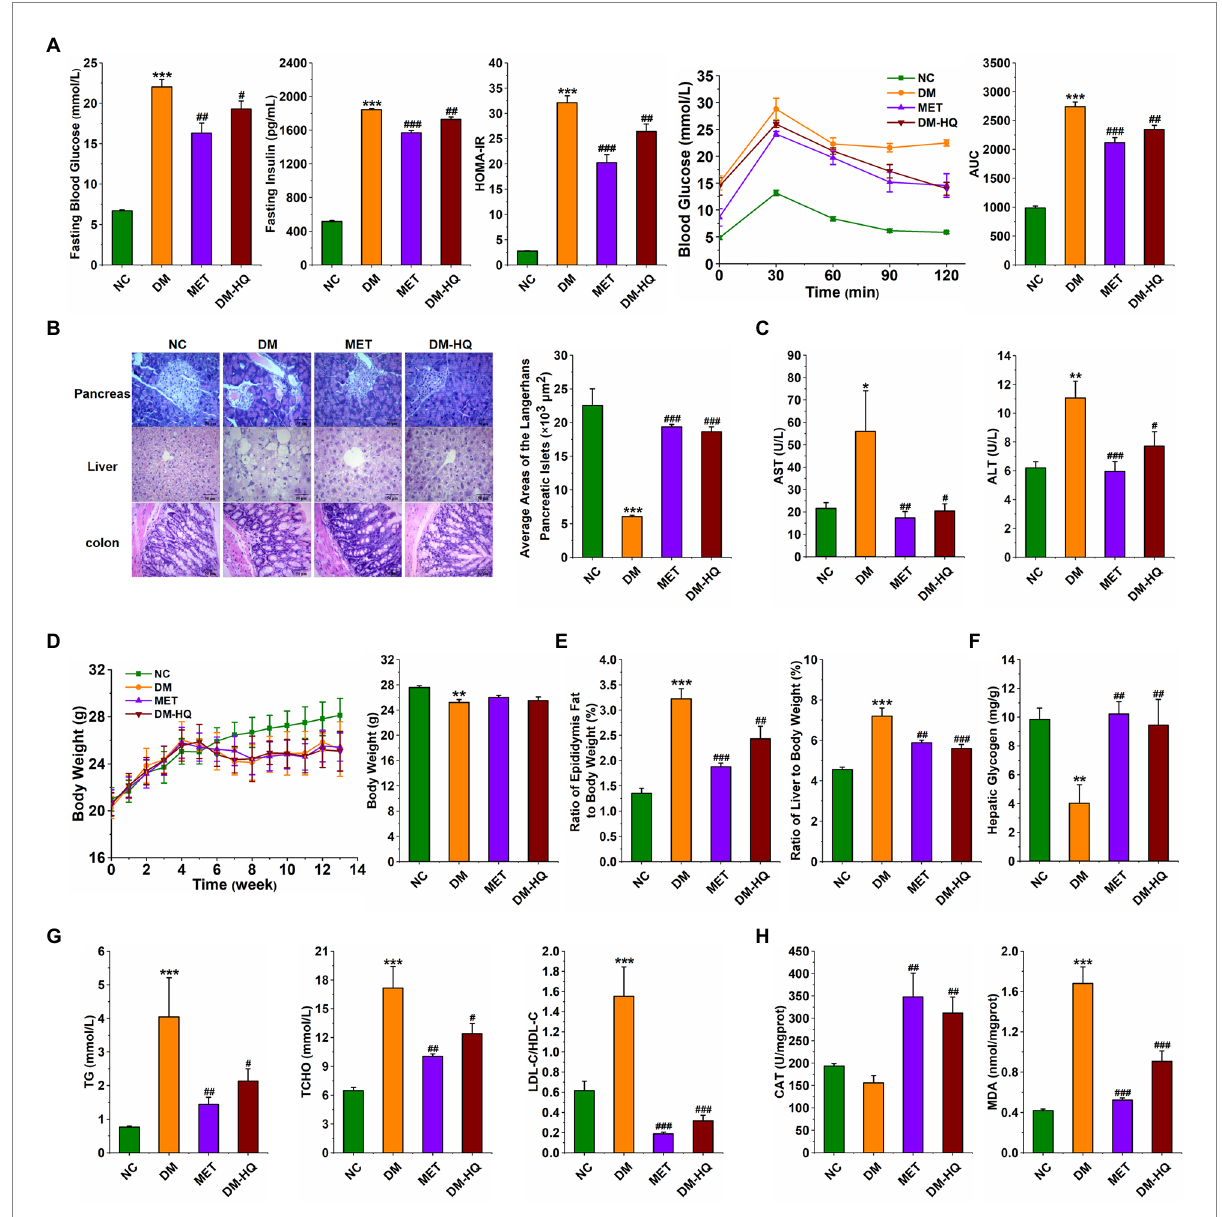
FIGURE 1 Huang-Qi-Ling-Hua-San (HQLHS) attenuated HFD and STZ induced type 2 diabetes. (A) Fasting blood glucose, fasting insulin level, homeostasis model assessment-insulin resistance (HOMA-IR), oral glucose tolerance test (OGTT), and area under the curve (AUC). (B) Morphological observation of pancreas (magnification, ×200, 50 μ m), liver (magnification, ×200, 50 μ m), colon (magnification, ×400, 50 μ m) with H&E staining, and the average area of the pancreatic islets of Langerhans. (C) Serum levels of aspartate aminotransferase (AST) and alanine aminotransferase (ALT). (D) The weekly weight change and the final weight at 13th week in the four groups. (E) Epididymal fat index and liver index. (F) Level of hepatic glycogen. (G) Blood triglycerides, cholesterol, LDL-C/HDL-C levels. (H) Serum levels of Catalase (CAT) and malondialdehyde (MDA). Data are expressed as mean ± SEM; One-way ANOVA was used to analyze statistical differences; Compare to NC: * p < 0.05; ** p < 0.01; *** p < 0.001; Compare to DM: # p < 0.05; ## p < 0.01; ### p <